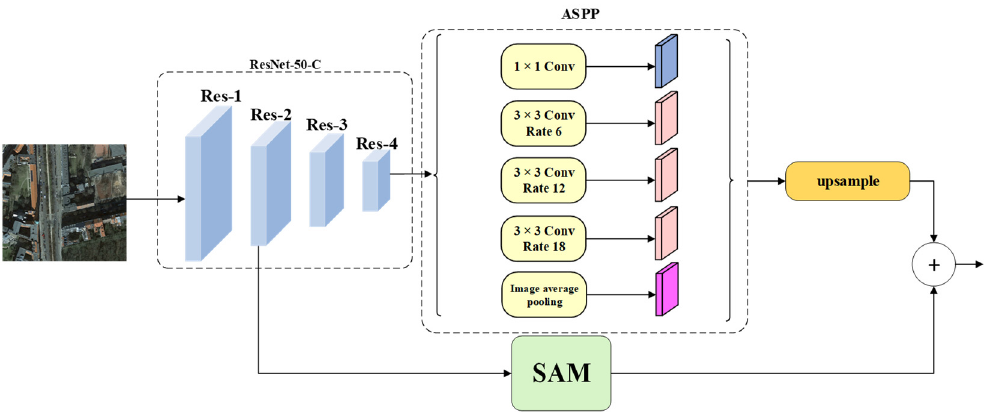
Figure 8. Structure of ablation study for the value of 𝑟 comparison